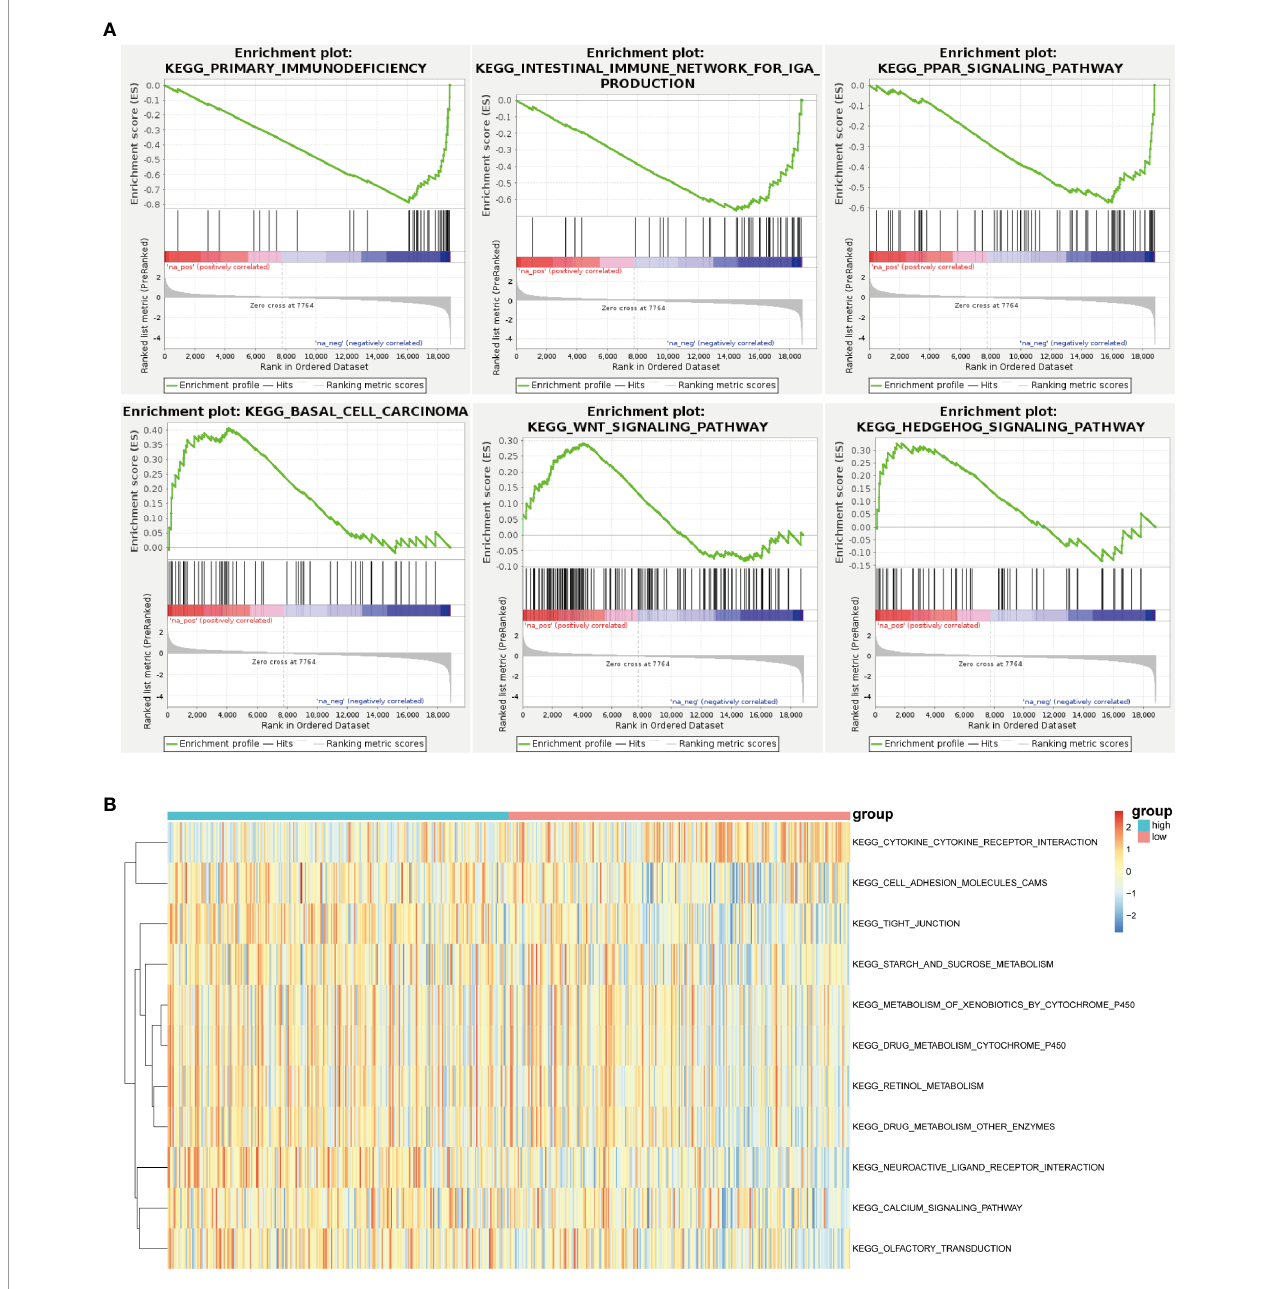
FIGURE 7 | Unsupervised consensus analysis of m 6 A regulatory genes. (A) GSEA revealed that the IGF2BP2 group was enriched in the hallmarks malignant progression and tumor immunology. (B) GSVA revealed the state of biological pathways in the high and low IGF2BP2 groups. The column represents the TCGA- HNSCC